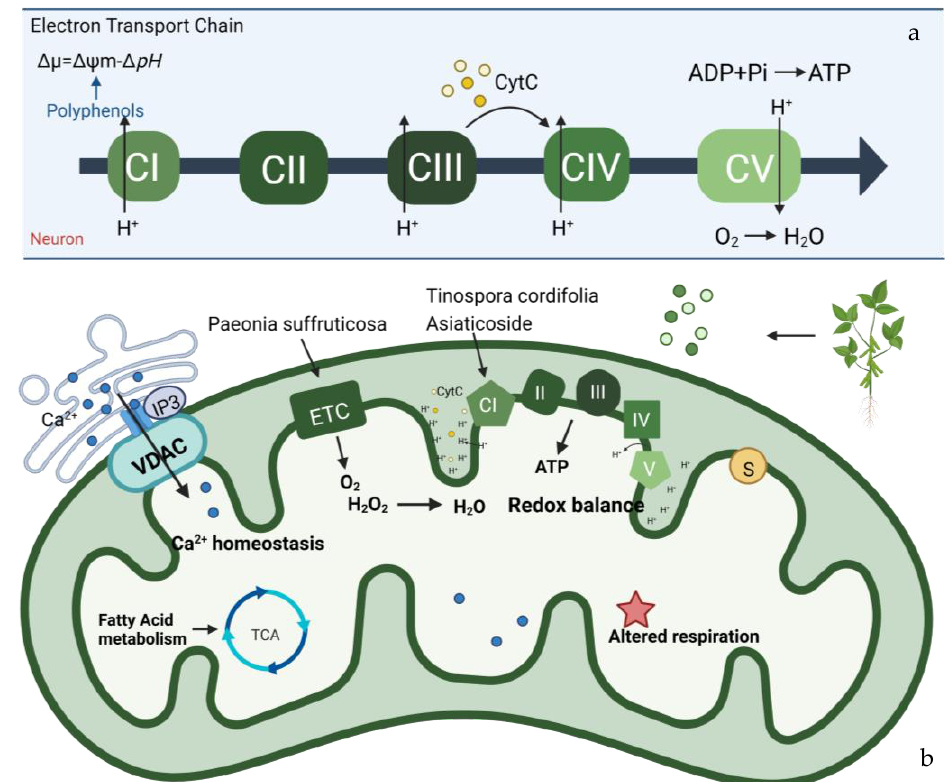
Figure 3. Mitochondrial bioenergy systems and plant-derived natural products improve mitochondrial productivity. ( a ) Electron transport chain (ETC). There are five polymerase complexes in the oxidative phosphorylation system: CI, CII, CIII, CIV, CV. In ETC, electrons are transferred from succinic acid to O 2 via cytochrome C (cyt C) to produce H 2 O and ATP. The mitochondrial membrane potential (∆Ψm) balance maintains mitochondrial homeostasis and its ability to produce ATP. ( b ) Biological function of mitochondrial proteins and factors influencing the function of the energy-producing OxPhos system. Affecting the stability of mitochondrial Ca 2+ channel, ETC channel, and other factors will have an impact on mitochondria. Some natural products from plants, such as Paeoina suffruticosa and Tinospora cordifolia , can regulate mitochondrial homeostasis.